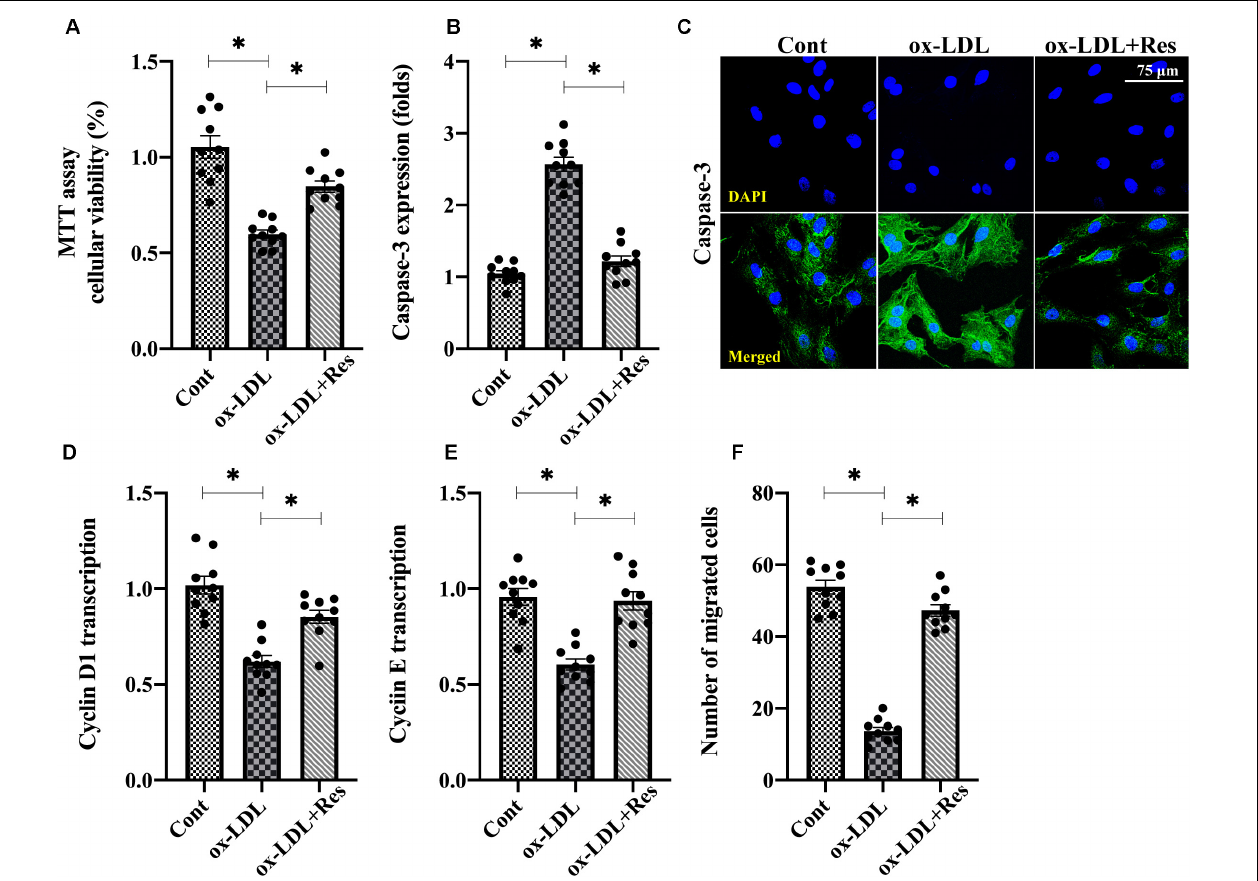
FIGURE 1 | Resveratrol ameliorates ox-LDL-mediated endothelial dysfunction. (A) HUVECs were incubated with ox-LDL in the presence or absence of resveratrol. Cell viability was determined through MTT assay. (B,C) Immunofluorescence staining was used to observe the alterations of caspase-3 in endothelial cells under ox-LDL treatment. (D,E) RNA was collected from HUVECs after treatment with ox-LDL in the presence or absence of resveratrol. Then, transcription of cyclin D1 and cyclin (E) were measured to reflect endothelial cell proliferation. (F) Transwell assay was used to detect endothelial cell migratory response. The number of migrated endothelial cells was recorded. * p <